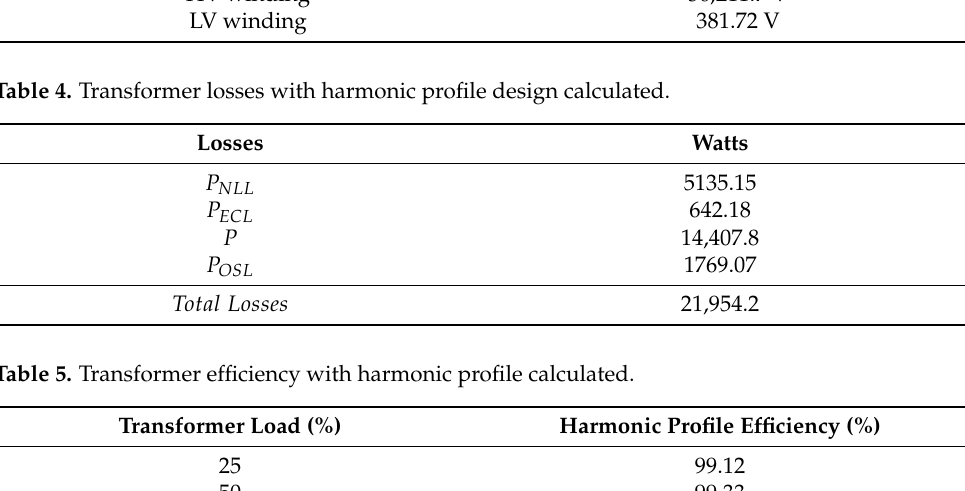
Table 3. Transformer winding voltages calculated under the harmonic profile.